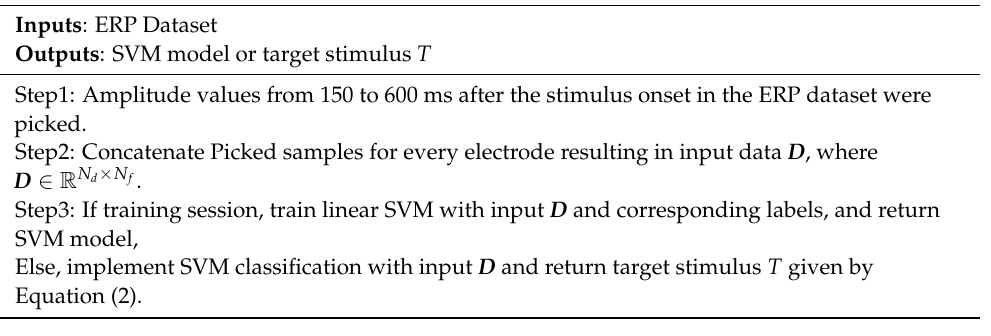
Algorithm 1 A pseudo-code for extracting features and classifying the target and non-target. Algorithm Feature Extraction and